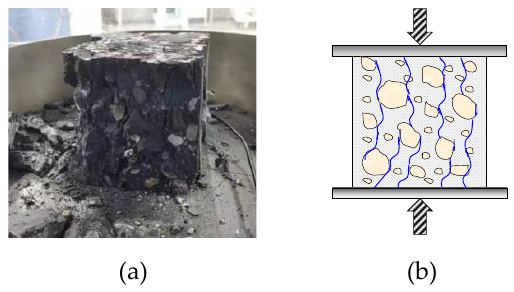
Figure 9. Failure pattern of C3. ( a ) appearance; ( b ) crack propagation.